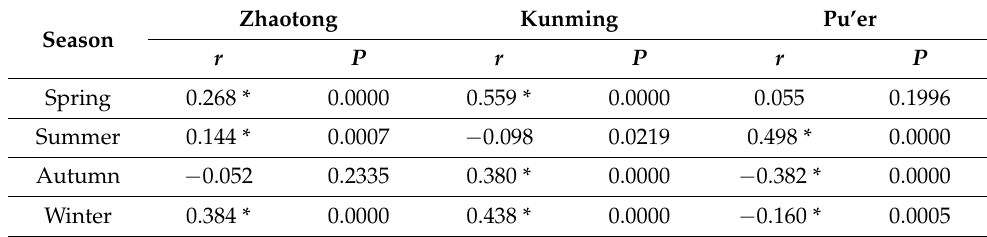
Table 1. Correlation Analysis of O 3 Concentration and Temperature in Different Seasons.